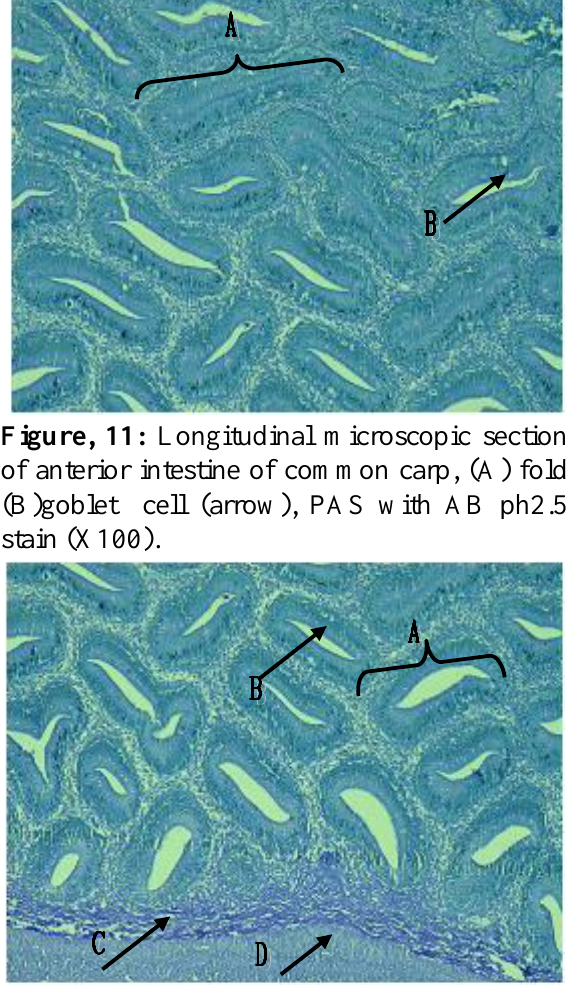
Figure, 12: Longitudinal microscopic section of posterior portion of intestine of common carp, (A) Fold,(B) goblet cell, (C) submucosa, (D) tunica muscularis, PAS with AB ph2.5 stain